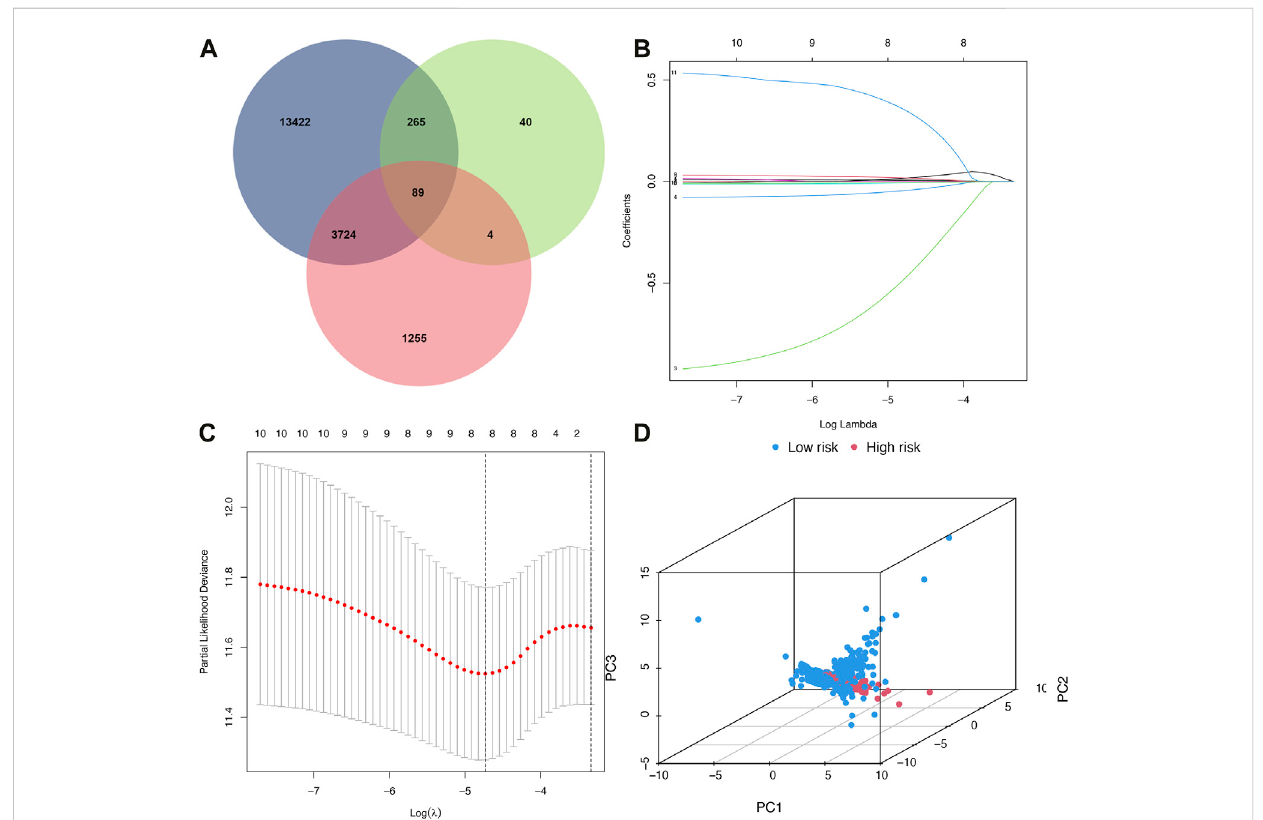
FIGURE 1 Buildariskmodel. (A) Venndiagram.Bluerepresentedimmunitygenes,greenrepresentedferroptosisgenes,andredrepresenteddifferentialgenes. (B) Distribution of LASSO regression coef fi cients for crossed genes. (C) LASSO deviation pro fi le of crossed genes. (D) PCA plot of high and low-risk group. PCA, principal component